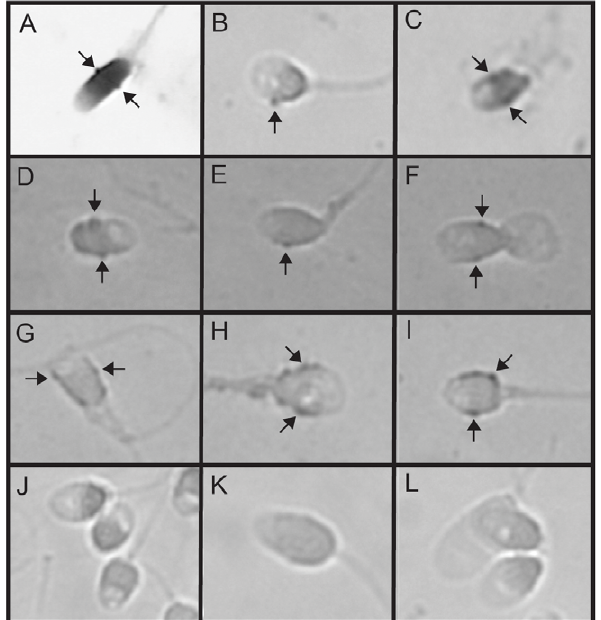
Figure 3. In situ hybridization on human sperm using HPV type-specific probes. Specific hybridizations are indicated by arrows. ( A – C ): In situ hybridization on an HPV-16 positive sperm sample using a probe specific for HPV-16. The sample in picture A was simultaneously background stained with hematoxylin. ( D – I ): In situ hybridization on an HPV-6 positive sperm sample using a probe specific for HPV-6. ( J – L ): In situ hybridization on an HPV negative sperm sample using a probe specific HPV-6. This figure is a representative of three independent in situ hybridization experiments using two different HPV-6 positive samples and two different HPV-16 positive samples.